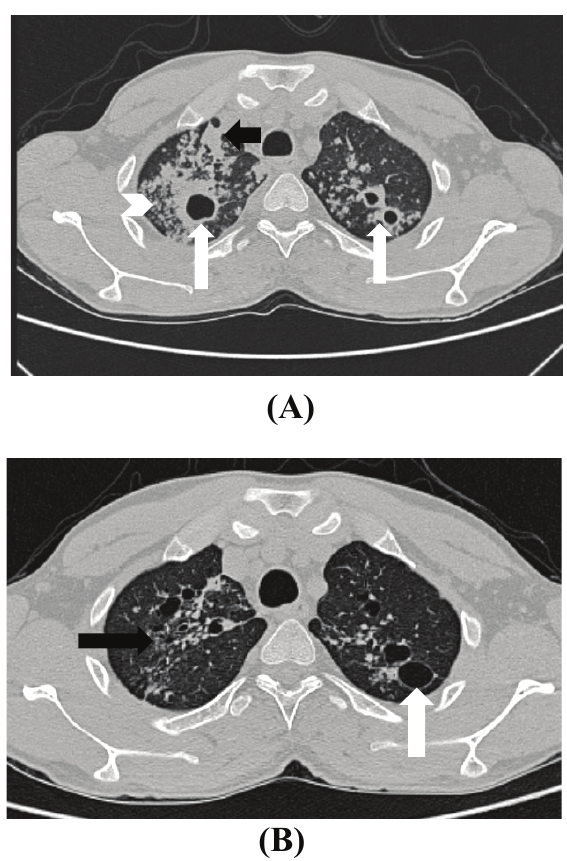
Figure 2 : Axial section of HRCT lung in case of tuberculosis at the subapical level. (A) HRCT scan acquired at the time of diagnosis showed multiple nodules with tree-in-bud appearance at places (arrowhead) and three large thick-walled cavities (white arrow) in bilateral upper lobes with patchy areas of consolidation (black arrow) in right upper lobe. (B) Follow-up HRCT obtained after six months of anti-tuberculous chemotherapy shows marked thinning of the wall of cavities (white arrow) with near complete resolution of nodules and consolidation. Fibrotic changes and focal areas of emphysema (black arrow) can also be noted.